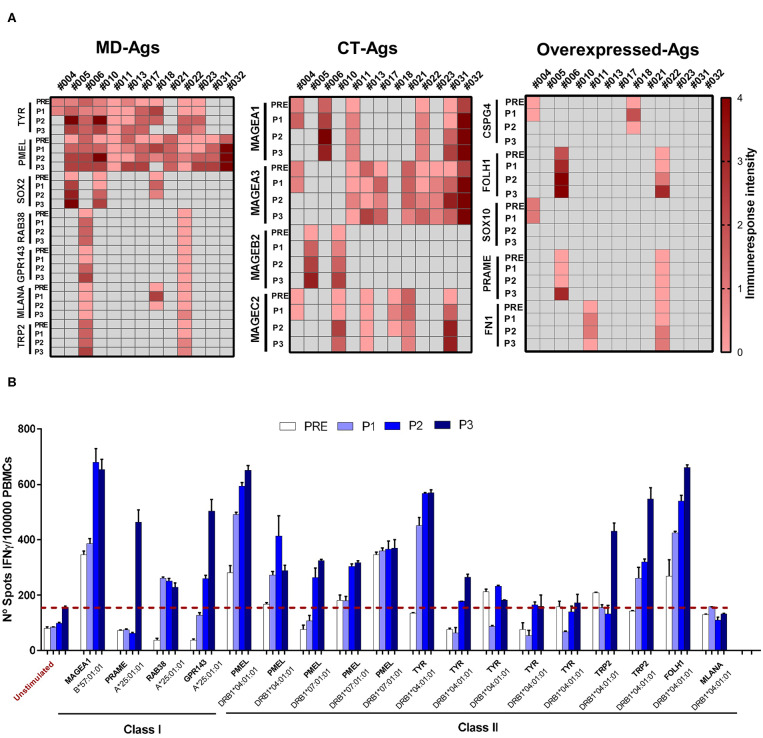
Assessment of T-cell responses against class I and class II TAAs-derived peptides throughout vaccination protocol. PBMC were cultured during 12 days with the corresponding target peptide (effector-cells). At day 13 peptide-loaded mitomycin C-treated APC and effector cells were seeded in ELISPOT plates and cultured O.N as described under Methods. At day 14, cells were removed and IFNγ spots were developed and quantified (up to 350 spots/well). (A) T-cell response triggered by TAA-derived peptides in 13 patients treated with CSF-470 vaccine. Each heat map column shows individual patient‘s response against different Ags (rows) of three categories: MD, CT, and overexpressed Ags. Intensity scale reflects the mean number of spots of all evaluated peptides for each Ags/105 effector cells, at the different time points (scale: 0 = no response, 1 = <175 spots, 2 = range 176–350, 3 = range 351–525, 4 = range 526–700). Black cells indicate neither peptide nor sample available for the patient. (B) Peptide testing for pt#006: the number of IFNγ spots/105 effector cells at different time points during the vaccination protocol (PRE to P3) are depicted. Peptide names and the corresponding HLA-presenting alleles are shown. Average of non-stimulated effector cells cultured with non-pulsed APC were used as a control to set unspecific spots (red-dashed line). Each sample was tested in triplicate; mean values + SD are shown. APC, antigen presenting cells; ON, overnight; MD, melanoma differentiation antigens; CT, cancer testis antigens.